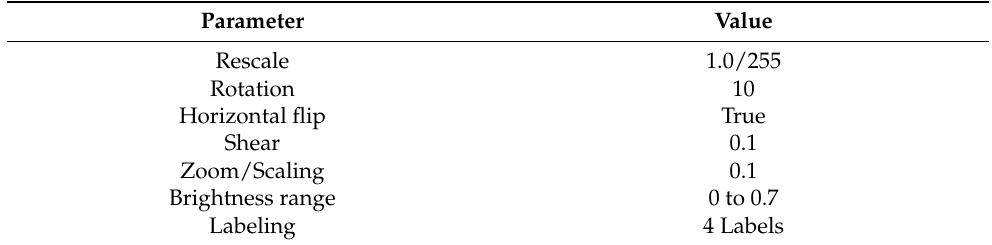
Table 1. Parameter values for the preprocessing stage for each CNN